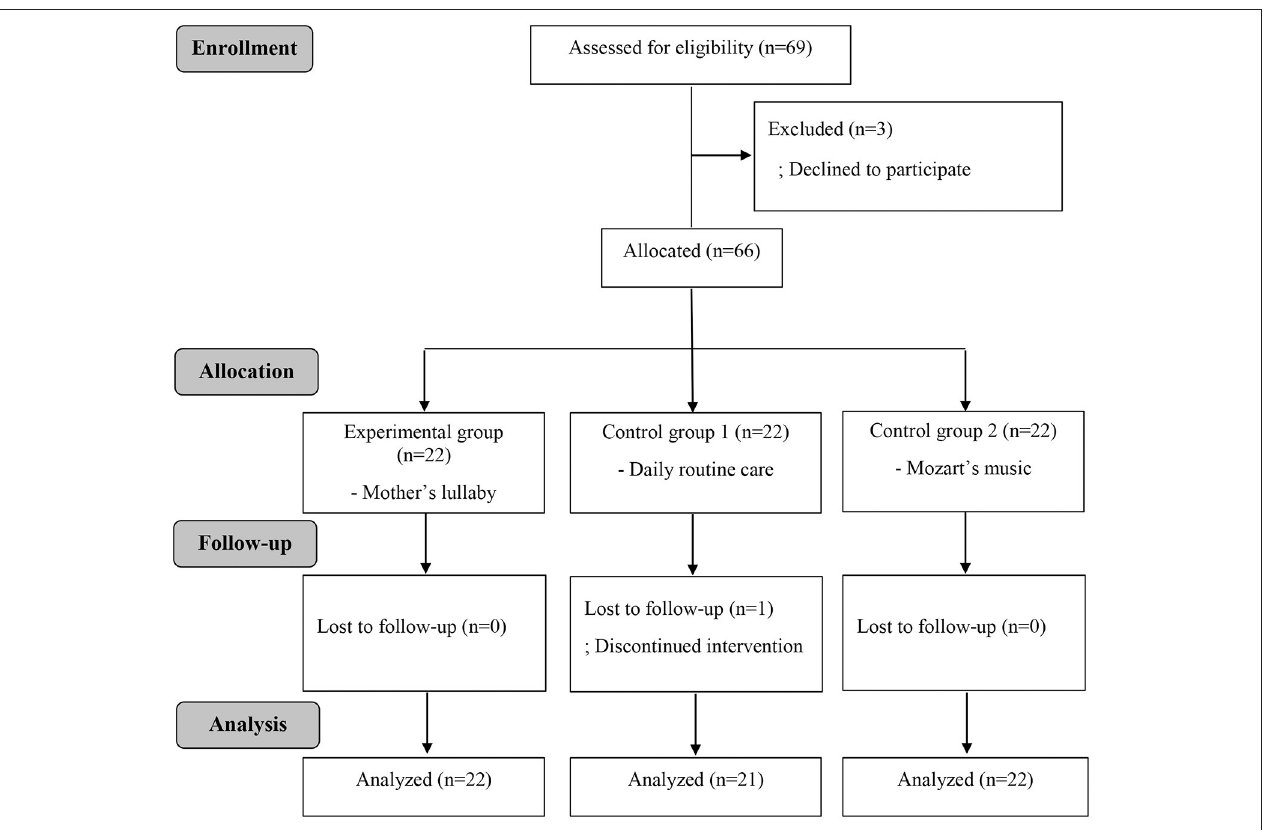
FIGURE 1 | Consort flowchart of the